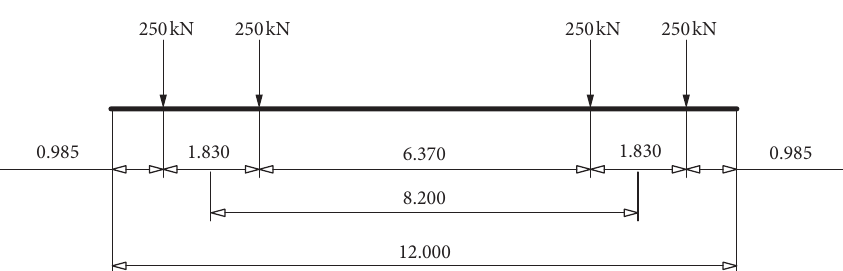
Figure 7: Load diagram of C80 special